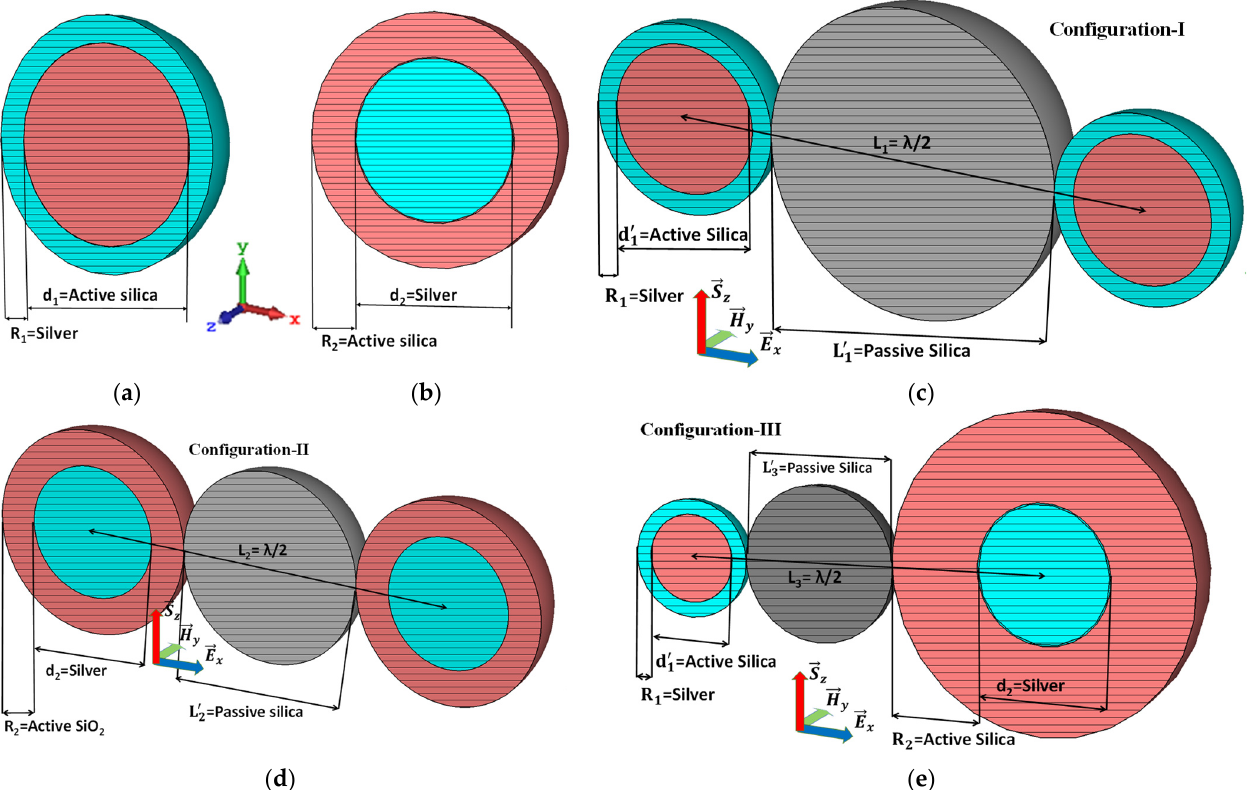
Figure 1. ( a ) CNP model where a silver shell of thickness R (cid:2869) = 10 nm encloses the core of active silica of diameter d (cid:2869) = 70 nm ; ( b ) I-CNP model. The shell of active silica has a thickness of R (cid:2870) = 60 nm , and the silver core has a diameter of d (cid:2870) = 94 nm ; ( c ) two CNPs separated by passive silica of diameter L (cid:2869)(cid:4593) = 172 nm ; ( d ) two I-CNPs separated by passive silica of diameter L (cid:2870)(cid:4593) = 36 nm ; ( e ) CNP and I-CNP separated by passive silica of diameter L (cid:2871)(cid:4593) = 104 nm .